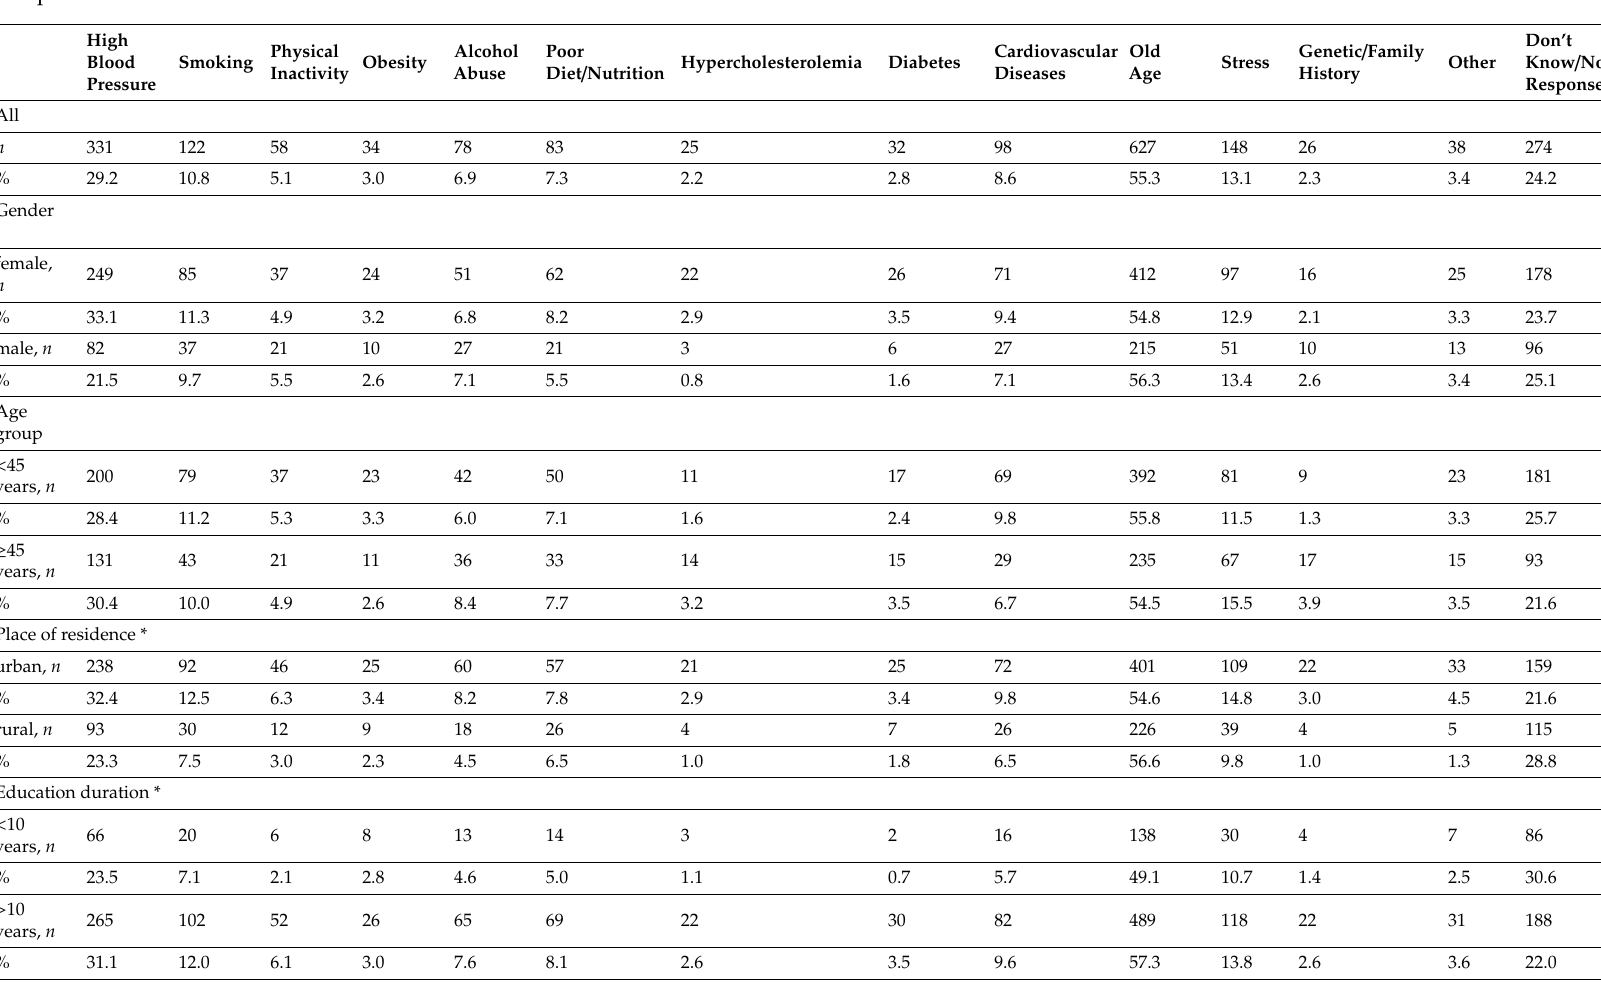
Cardiovascular Old Genetic / Family Stress Diseases Age History